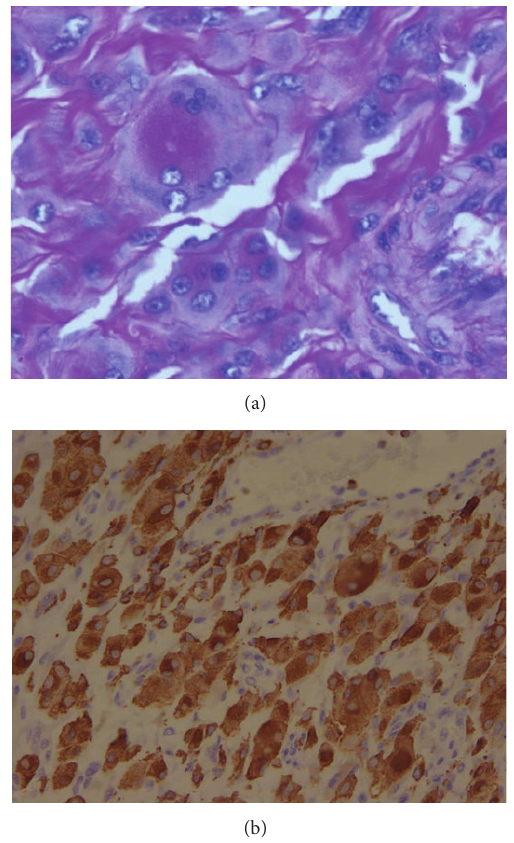
Figure 5: (a) Histiocytes with PAS material; (b) histiocytes staining positive for